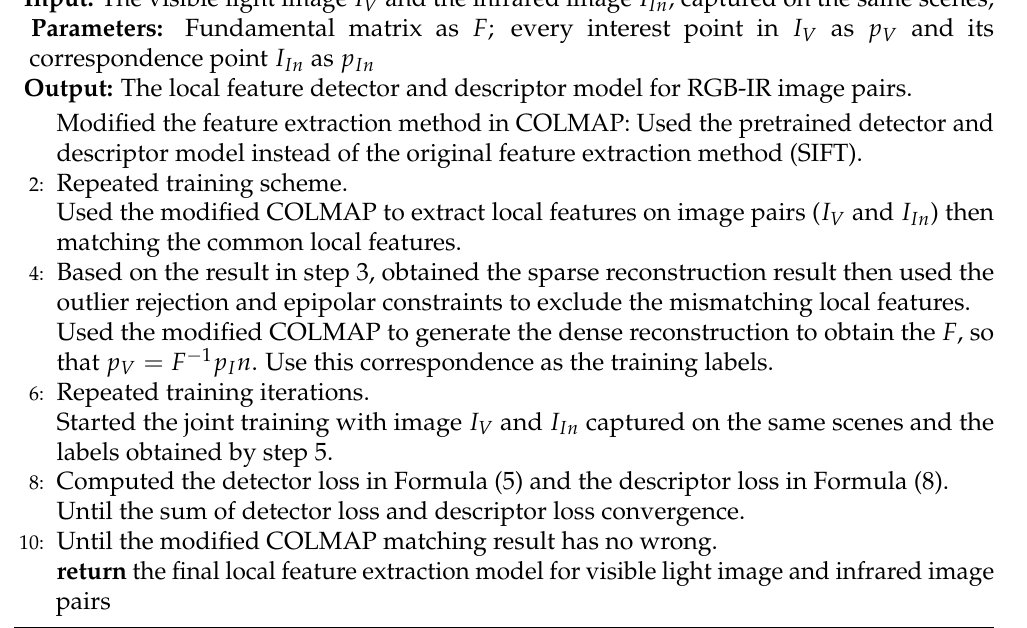
Algorithm 2 Train stage 2: Self-labelled local feature detector and descriptor model trained on visible light image and infrared image